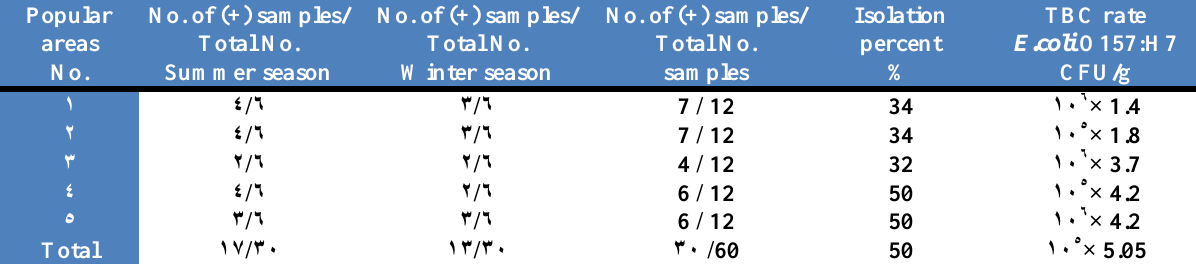
Table, 3: Samples TBC compared rates for both summer and winter season. CFU